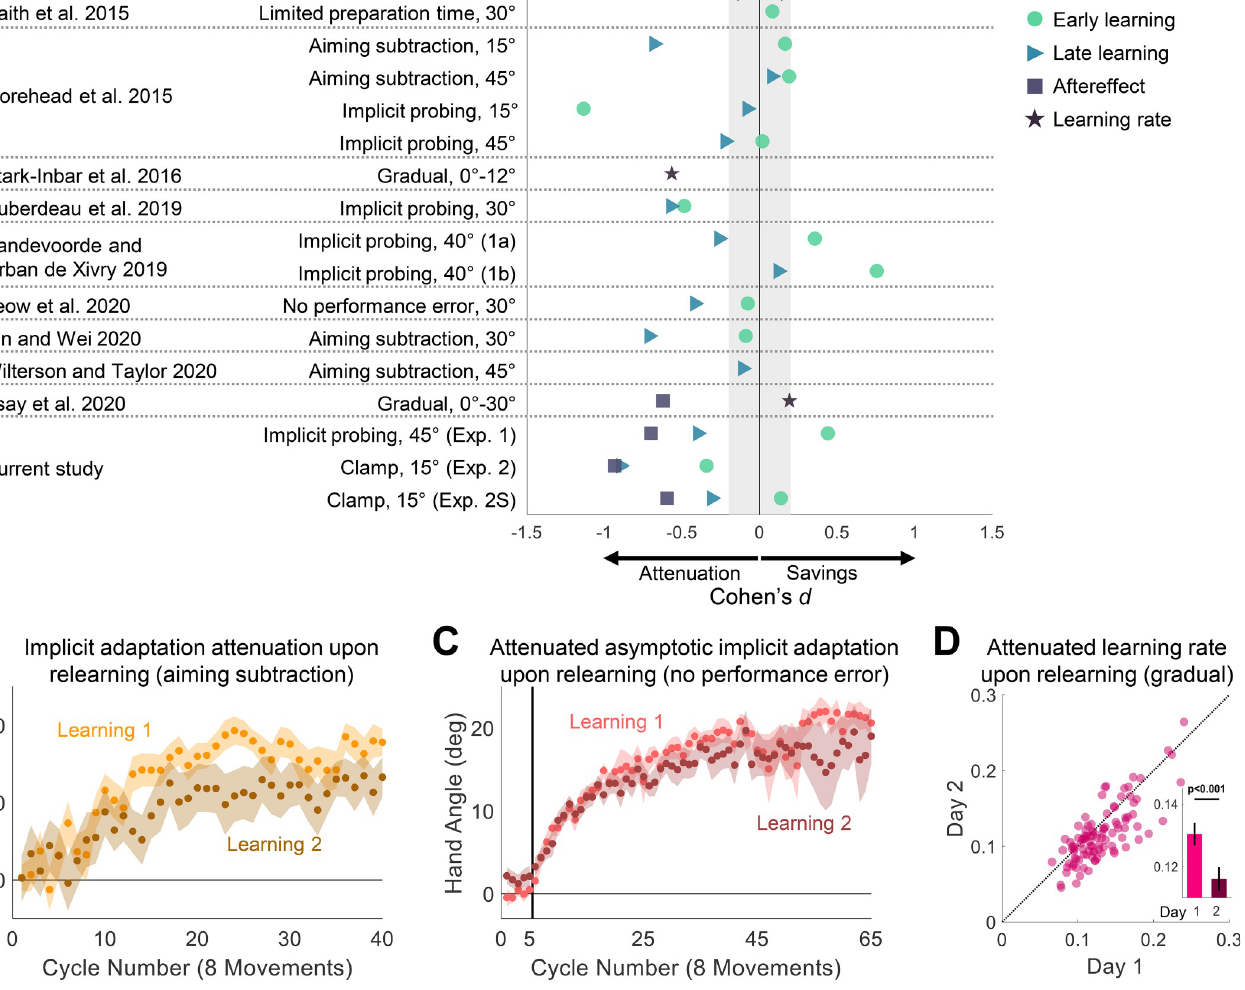
PLOS Biology | https://doi.org/10.1371/journal.pbio.3001147 March 5,